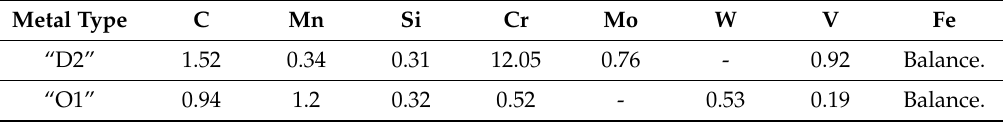
Table 1. Chemical composition of “D2” and “O1” tool steels in mass percent